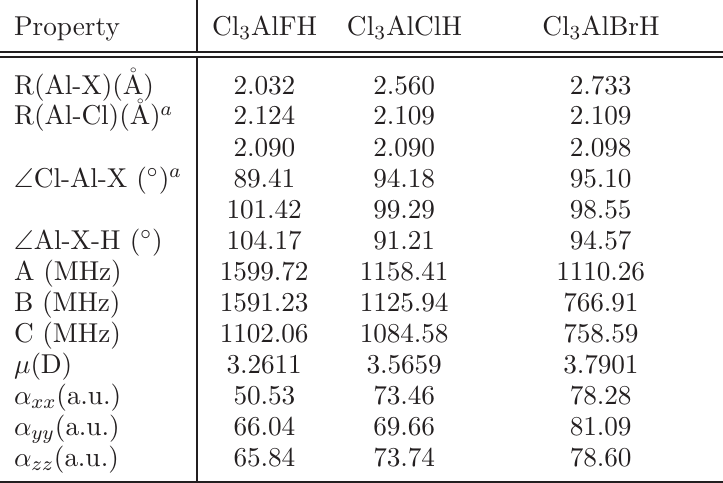
moments and static polarizability of the stable Cl plexes (X = F, Cl, and